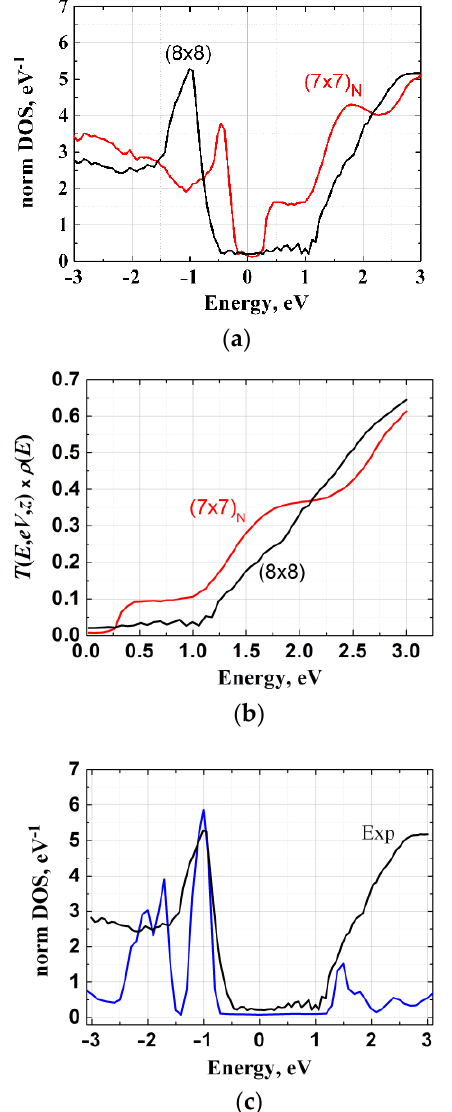
Figure 8. ( a ) Comparison of the corrected DOS of (7 × 7) N and (8 × 8) structures. ( b ) Comparison of the product T(E) × ρ s (E) for the (7 × 7) N and (8 × 8) structures. ( c ) Comparison of the empirical DOS of the (8 × 8) structure with the DOS of g-Si 3 N 3 from the theoretical work Guo et al. [42].